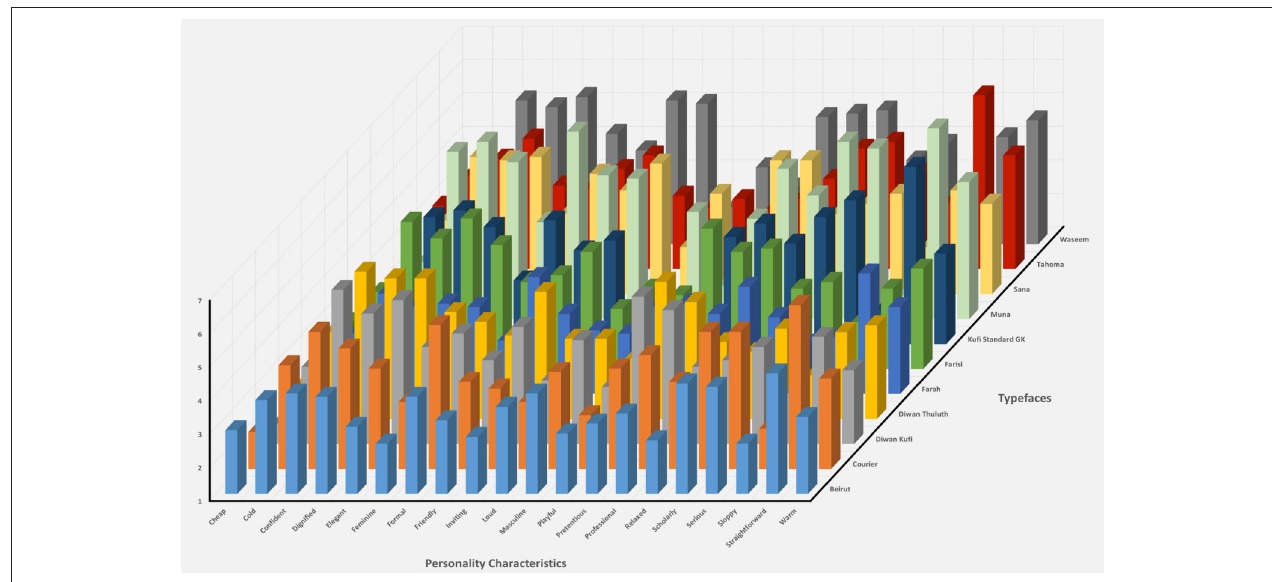
FIGURE 1 | The rating of personality characteristics for each